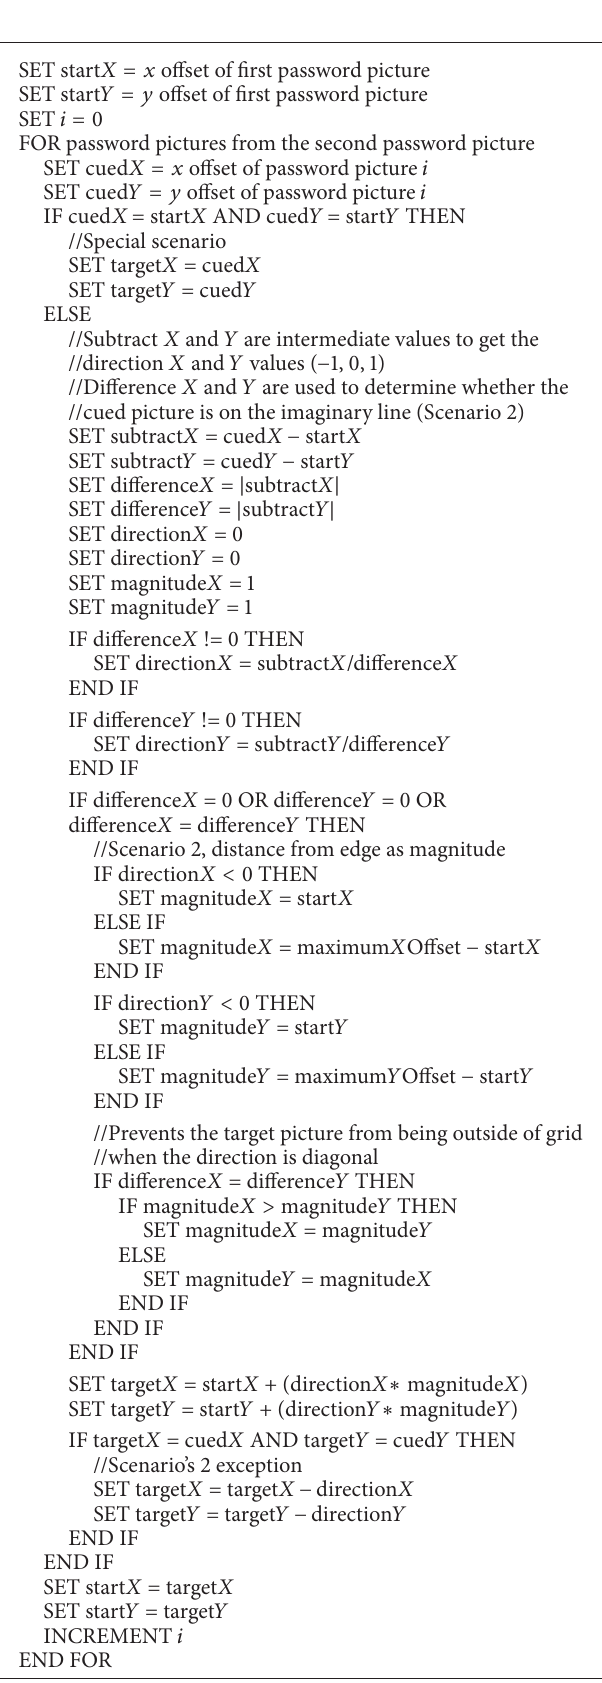
Algorithm 1: Pseudocode for the proposed